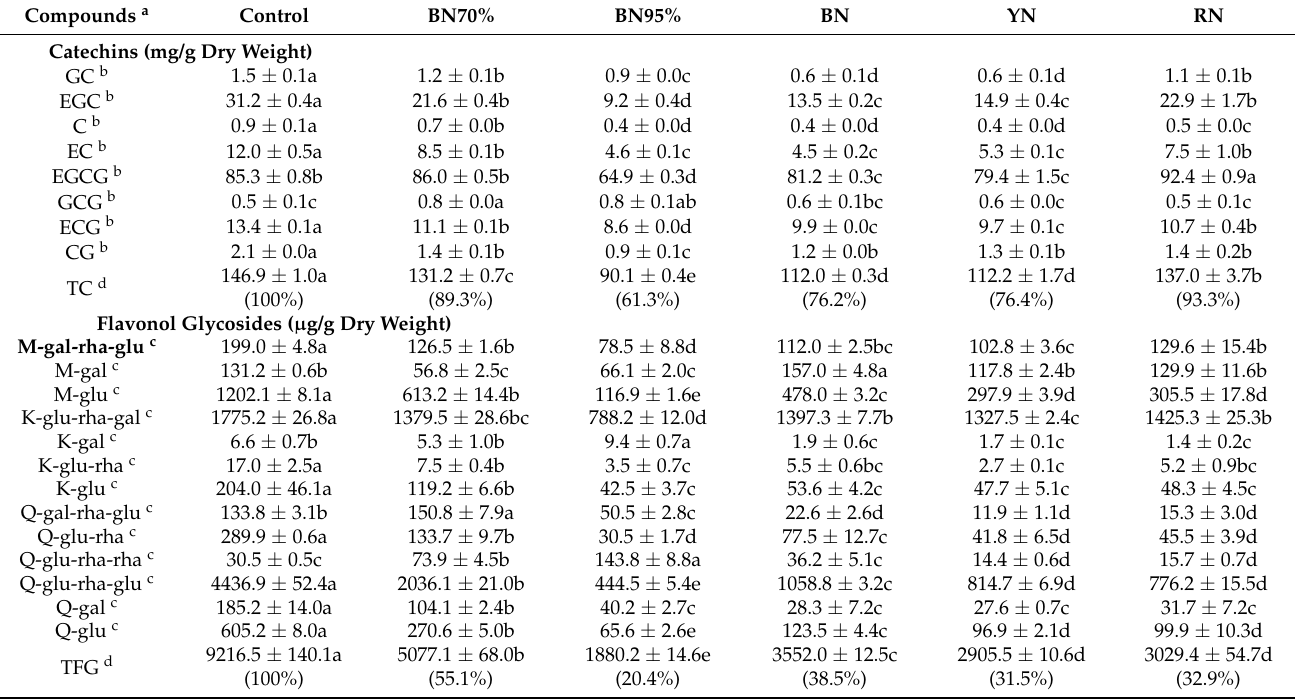
Table 1. The contents of catechins and flavonol glycosides in the fresh tea leaves under different shade treatments. Compounds